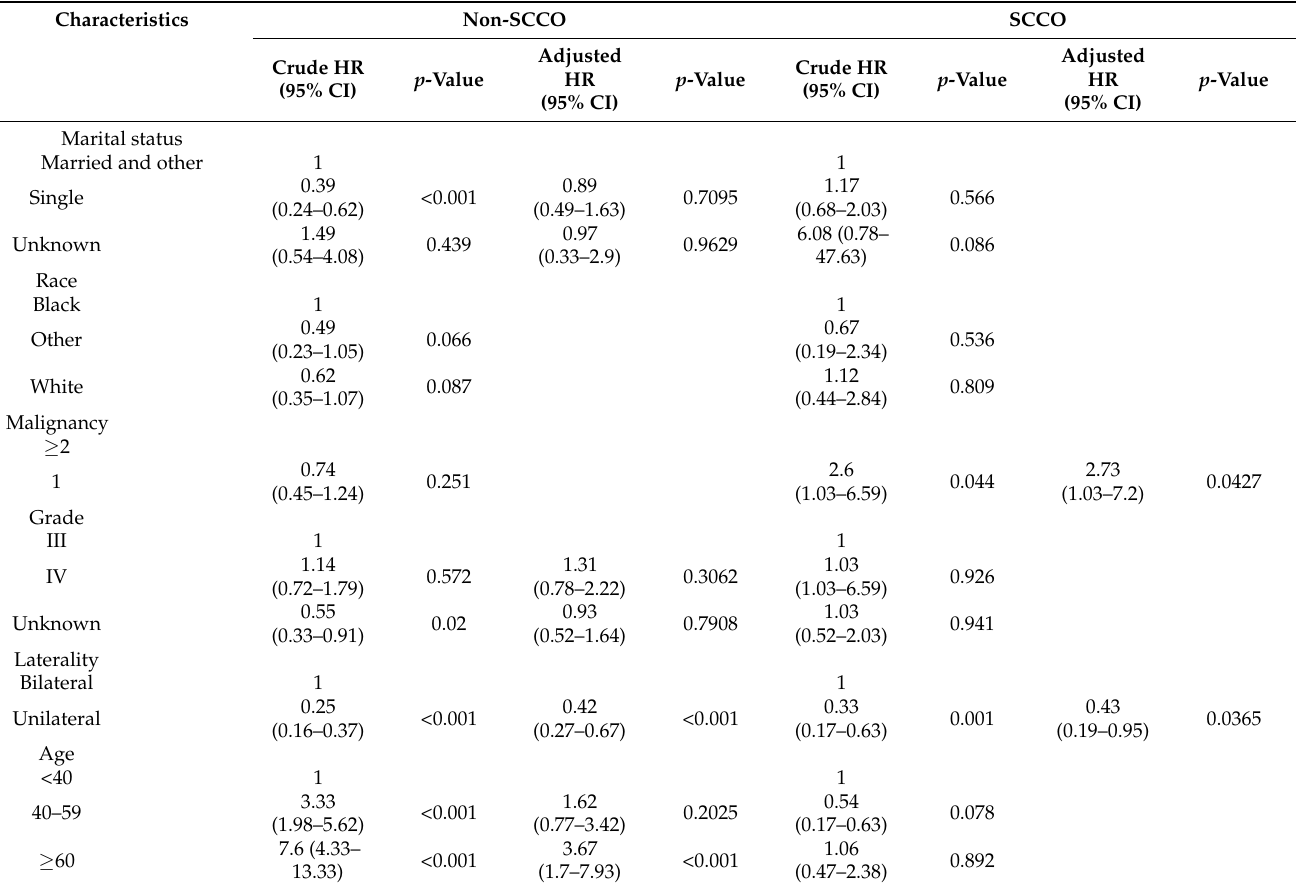
Table 2. Univariable and multivariable Cox regression models for overall survival among patients with non-SCCO and SCCO in matched